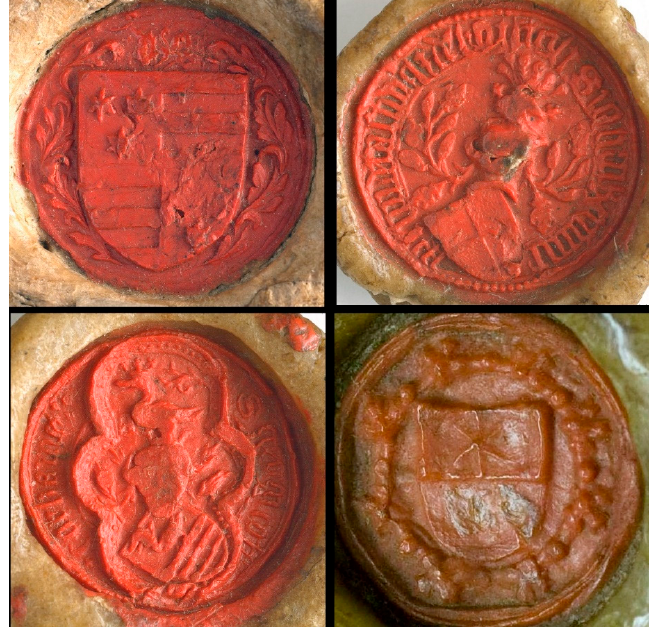
Figure 5. Seals of Ulrich, count of Cillei/Cilli/Celje ( top-left corner ), John Kórógyi, count of Castell ( top-right corner ), and Gregory Korbáviai, count of Korbávia (Krbava, bottom-left corner ) from 1440. Archiwum G ł ówne Akt Dawnych Zbior Doc. Perg. Nr. 5574. (Memoria Hungariae 2015, 11342., 11344., 11345.). The seal of Stephen Frangepán/Frankopan, count of Veglia/Krk, Zengg/Senj and Modrus/Modruš ( bottom-right corner ) from 1451 (MNL OL DL 2009, 33 986.).